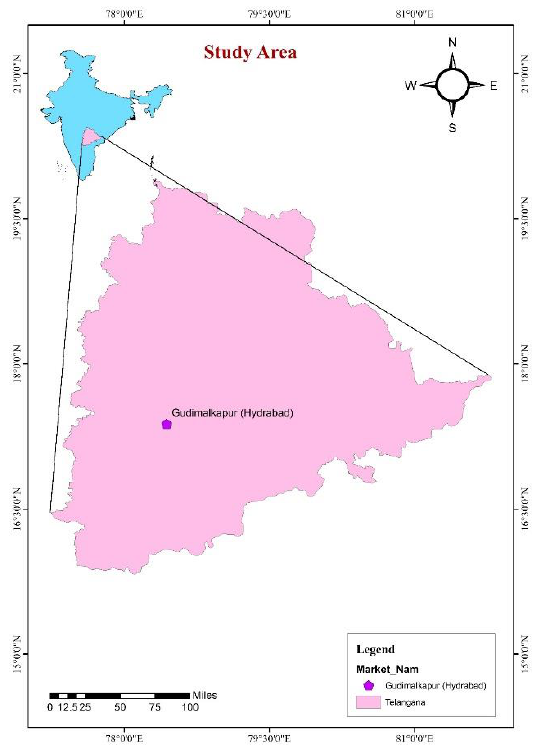
Figure 1. Map of the study